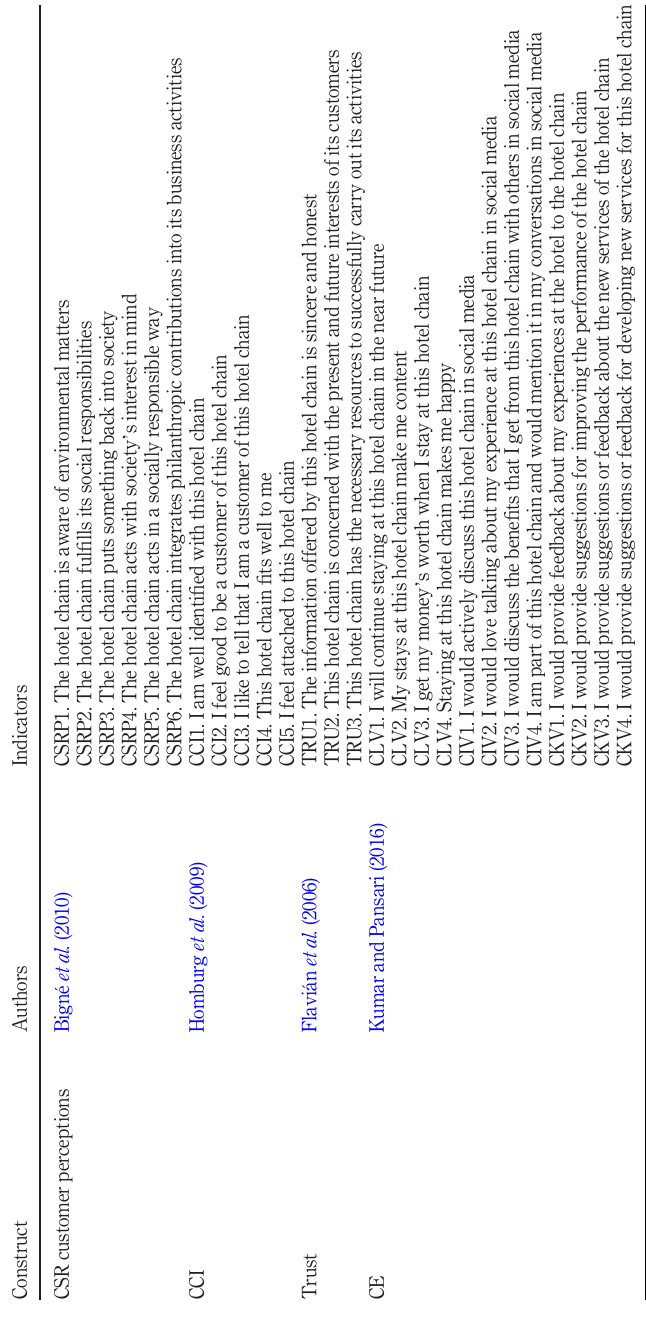
Table IV. Measurement